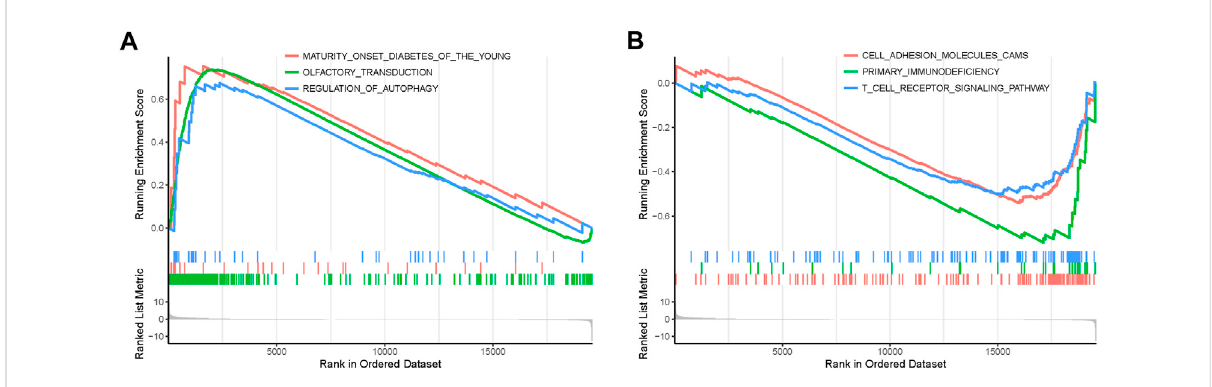
FIGURE 7 KEGG pathways of mRNAs inthe early- and progressive-stage STAD cohorts via GSEA. (A) Enriched pathways in early-stage STAD. (B) Enriched pathways in progressive-stage